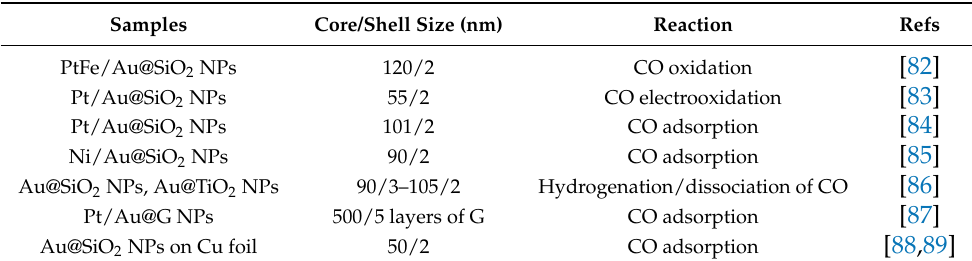
Table 1. Shell-isolated nanoparticle Raman spectroscopy (SHINERS) application to the reactions with CO molecules (NPs = nanoparticles; G =